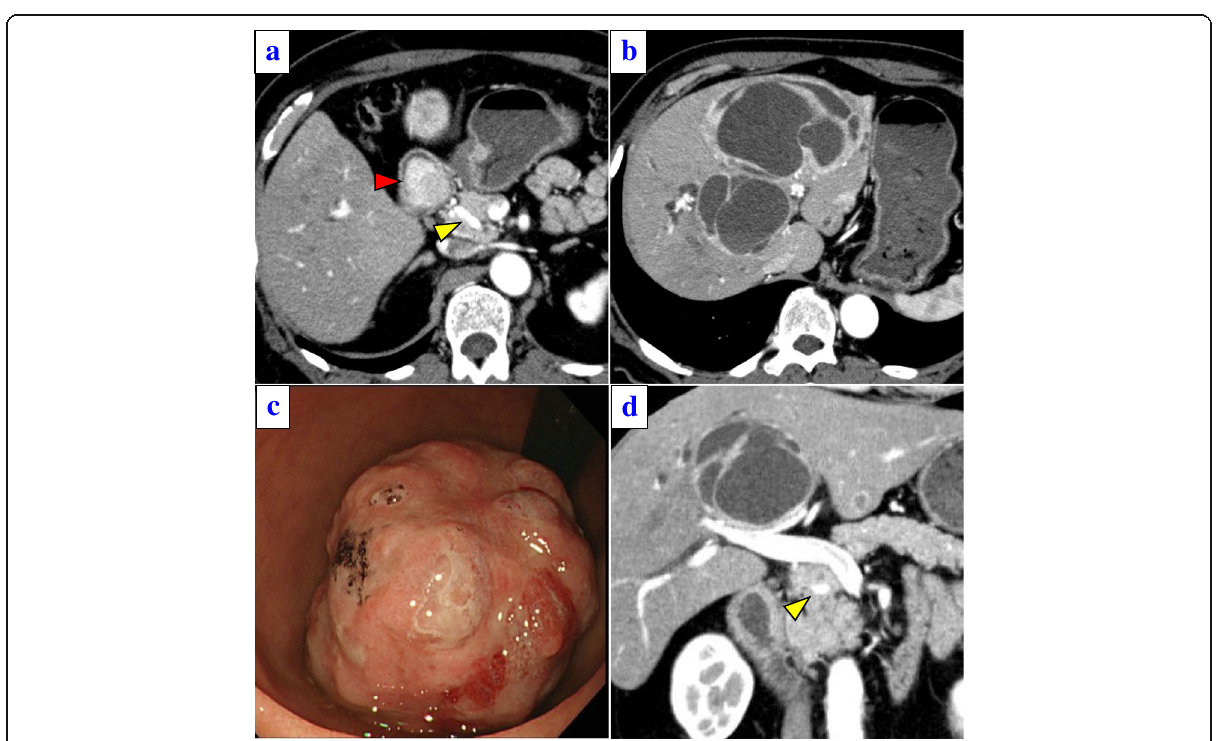
Fig. 1 a A duodenal tumor with increased contrast enhancement was observed (red arrow). In addition, the common hepatic artery (CHA) (yellow arrow) branched from the superior mesenteric artery (SMA), passing through the pancreatic head. b Abdominal CT showed multiple metastases in the left three lobes of the liver. c A 3.5-cm-diameter type 1 tumor in the descending portion of the duodenum was revealed by gastroscopy. d A coronal image. The yellow arrow is the CHA branching from the SMA, passing through the pancreatic